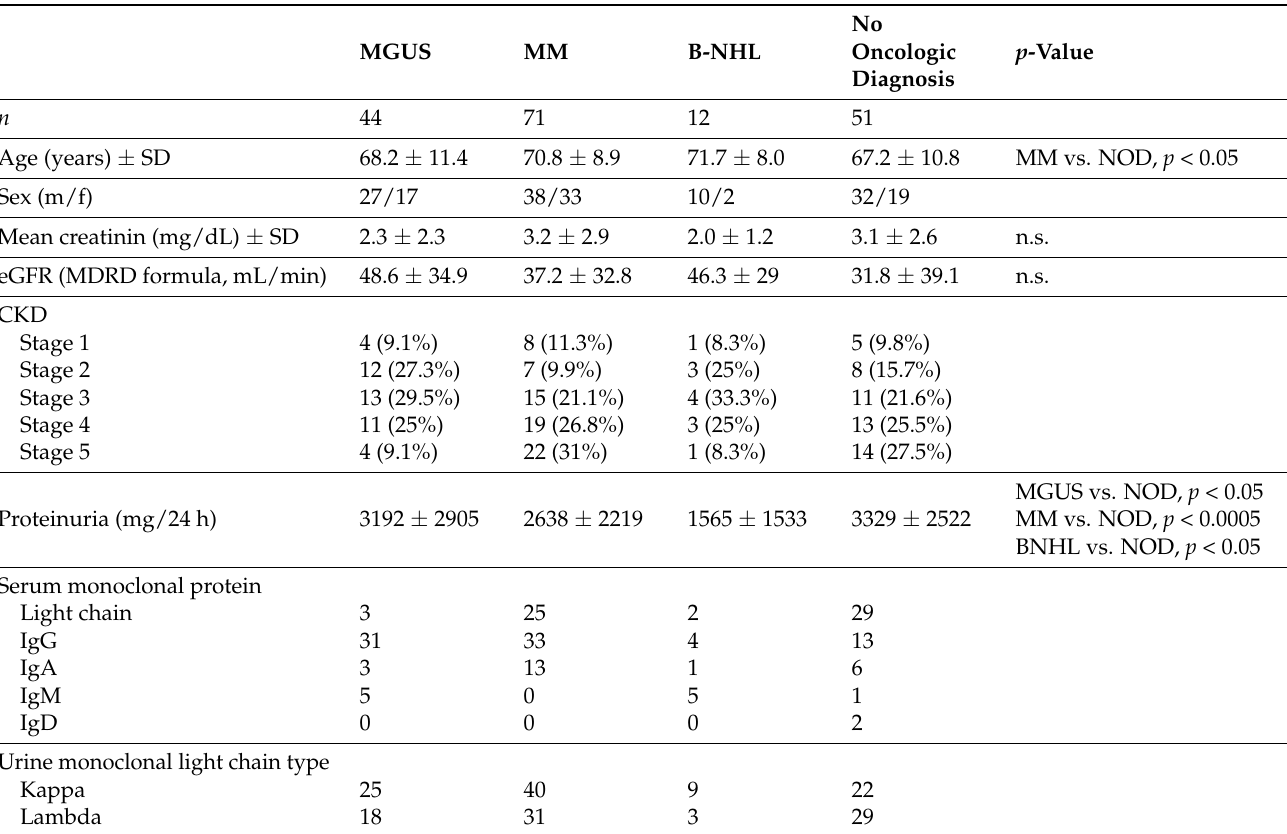
Table 1. Clinical characteristics before